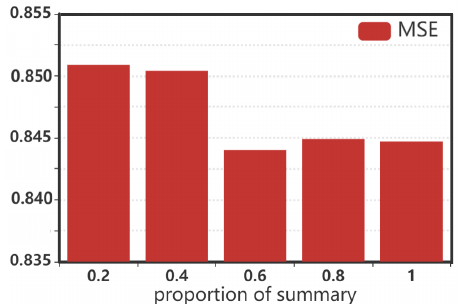
Figure 3. MSEs with different proportions of the review summary.